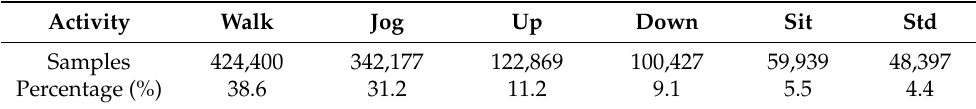
Table 2. Activities of wireless sensor data mining (WISDM) [1].